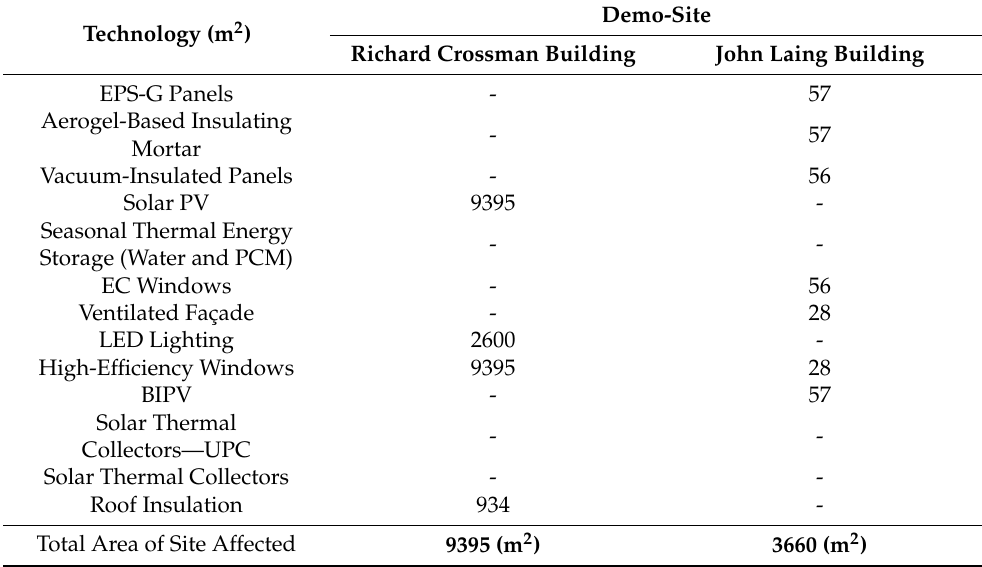
Table 4. Summary of retrofit